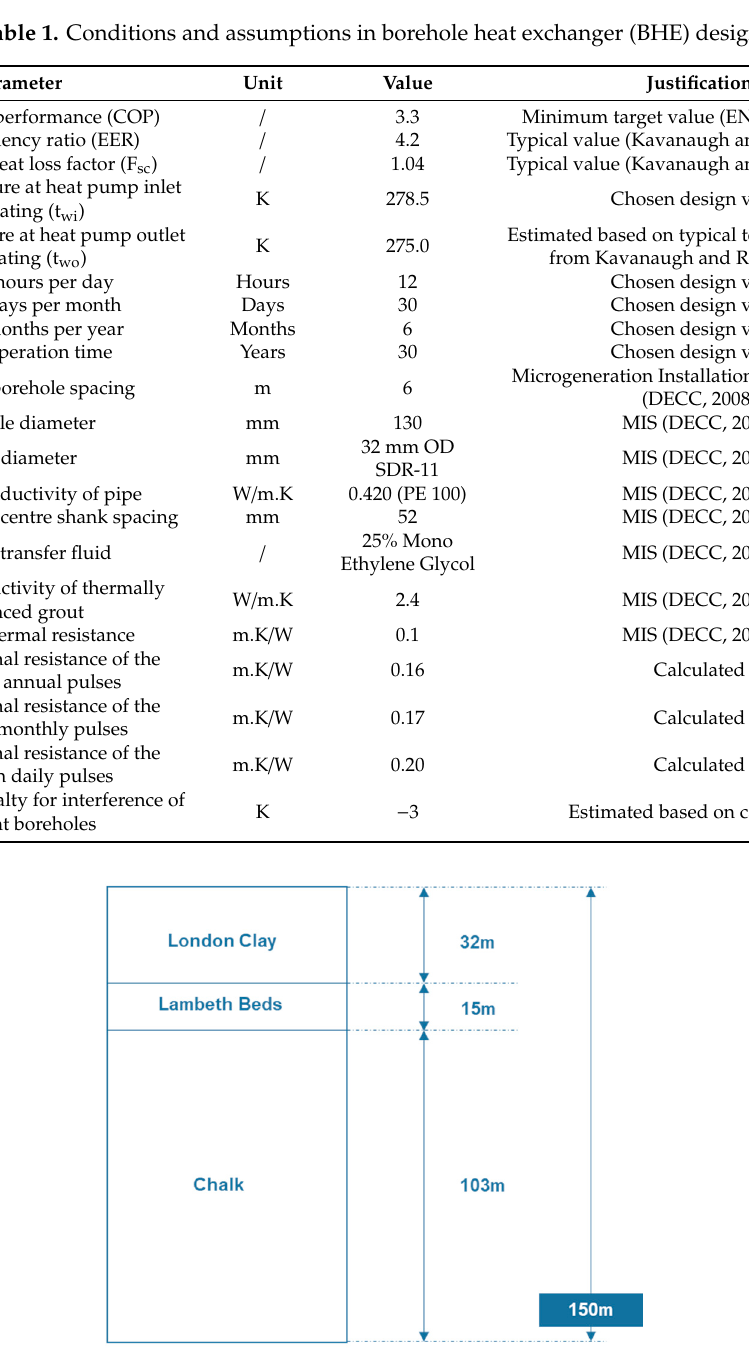
Figure 2. Geological cross-section.